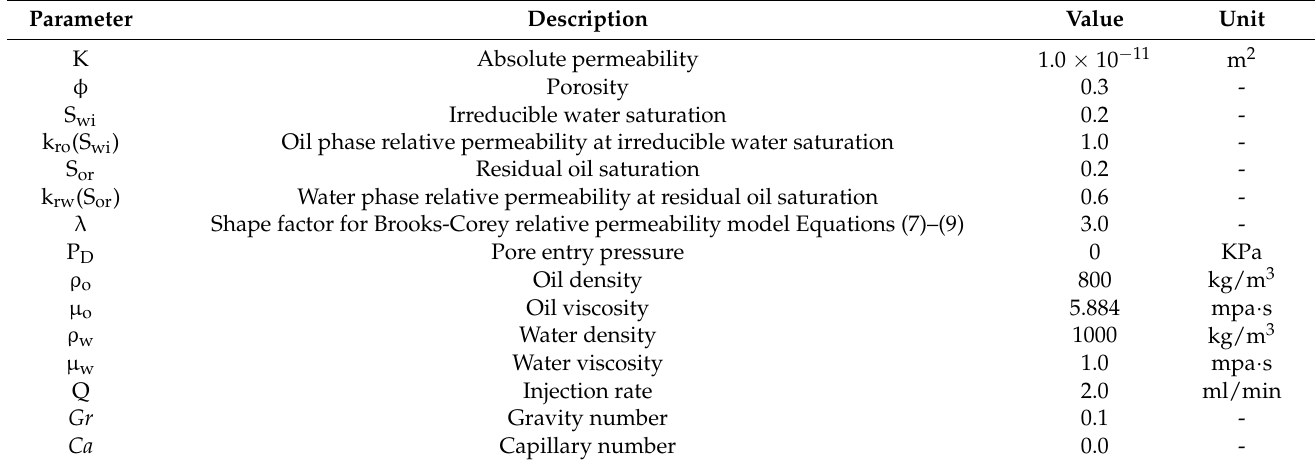
Table 2. Parameters used in numerical simulation for the single-vug model.